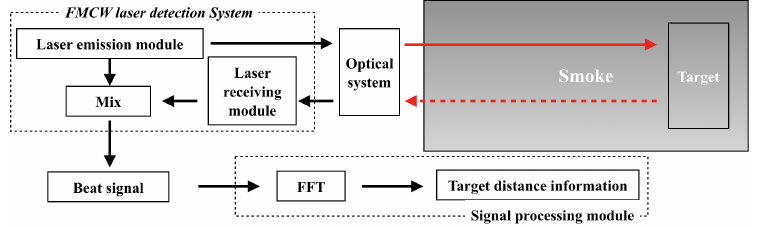
Figure 1. Block diagram of FMCW laser fuse detection